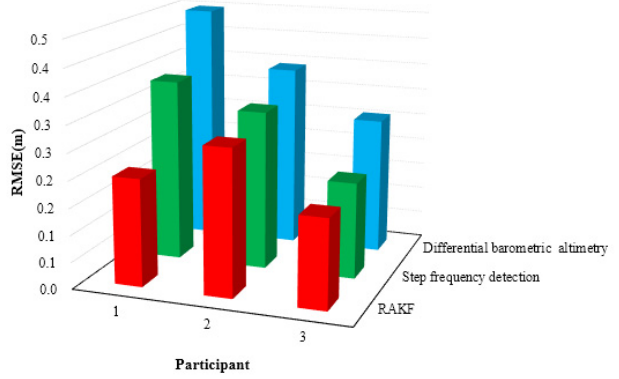
Figure 5. Distributions the RMSE of the height in location tracking for three participants.